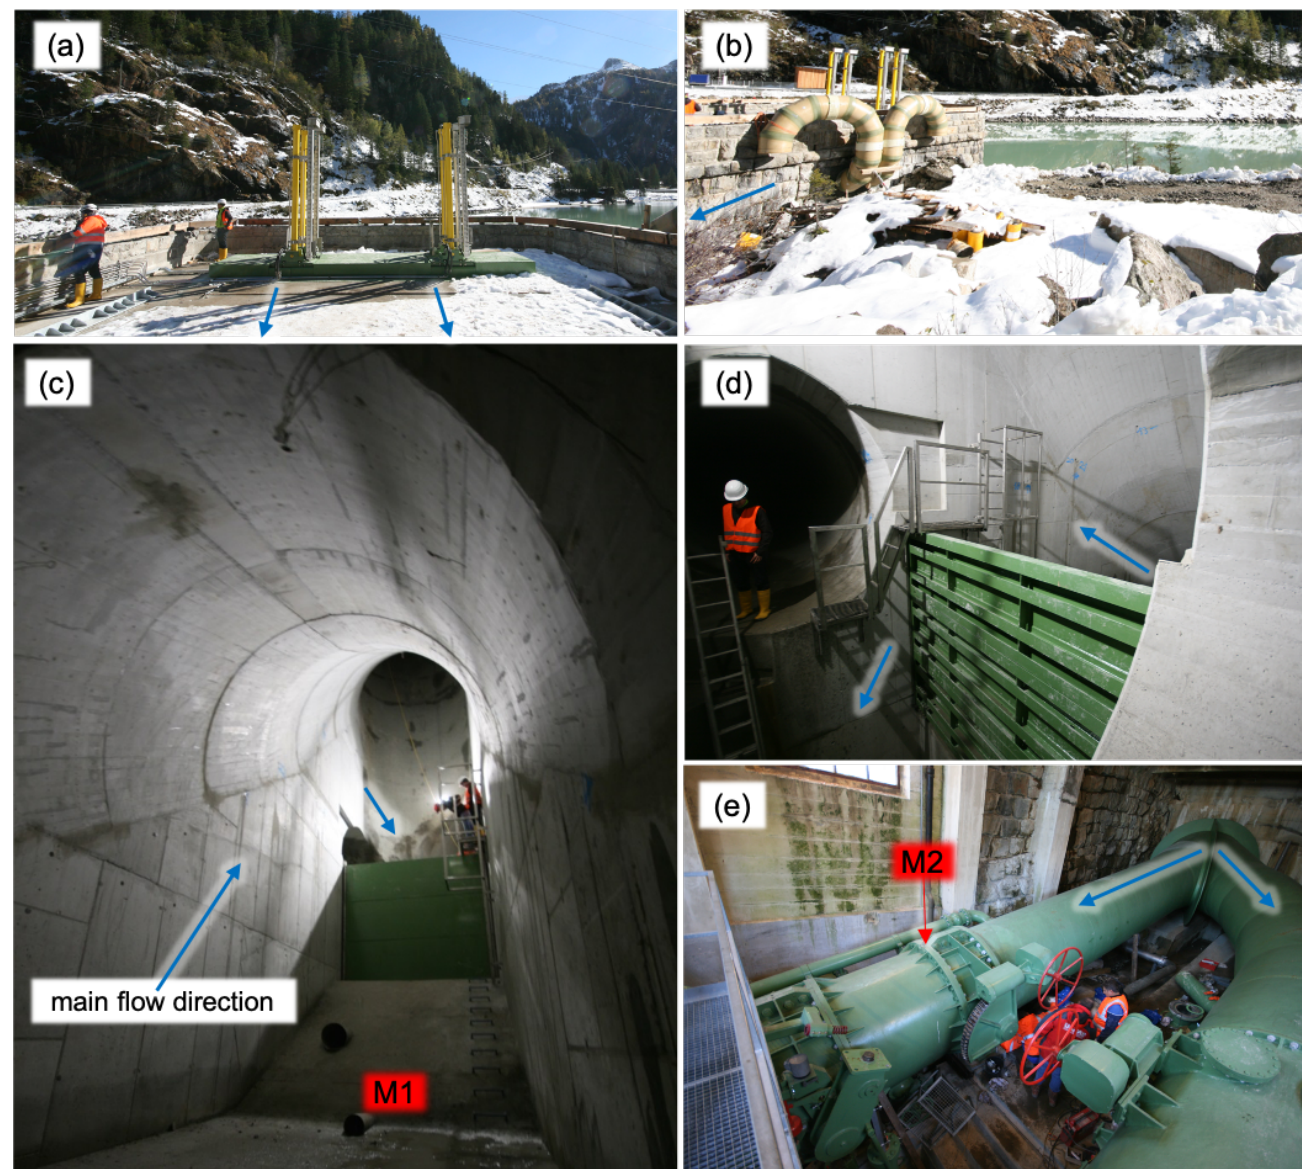
Figure 1. Main components of the new protection concept—intake gates ( a ) with additional ventilation ( b ); the new wall at the bottom of the surge tank ( c , d ) and division of the two penstocks including the valves ( e )—blue arrows indicate the main flow direction under normal operation— M 1 indicates the filling pipe which was used as an upstream measurement point and M 2 marks the downstream measurement